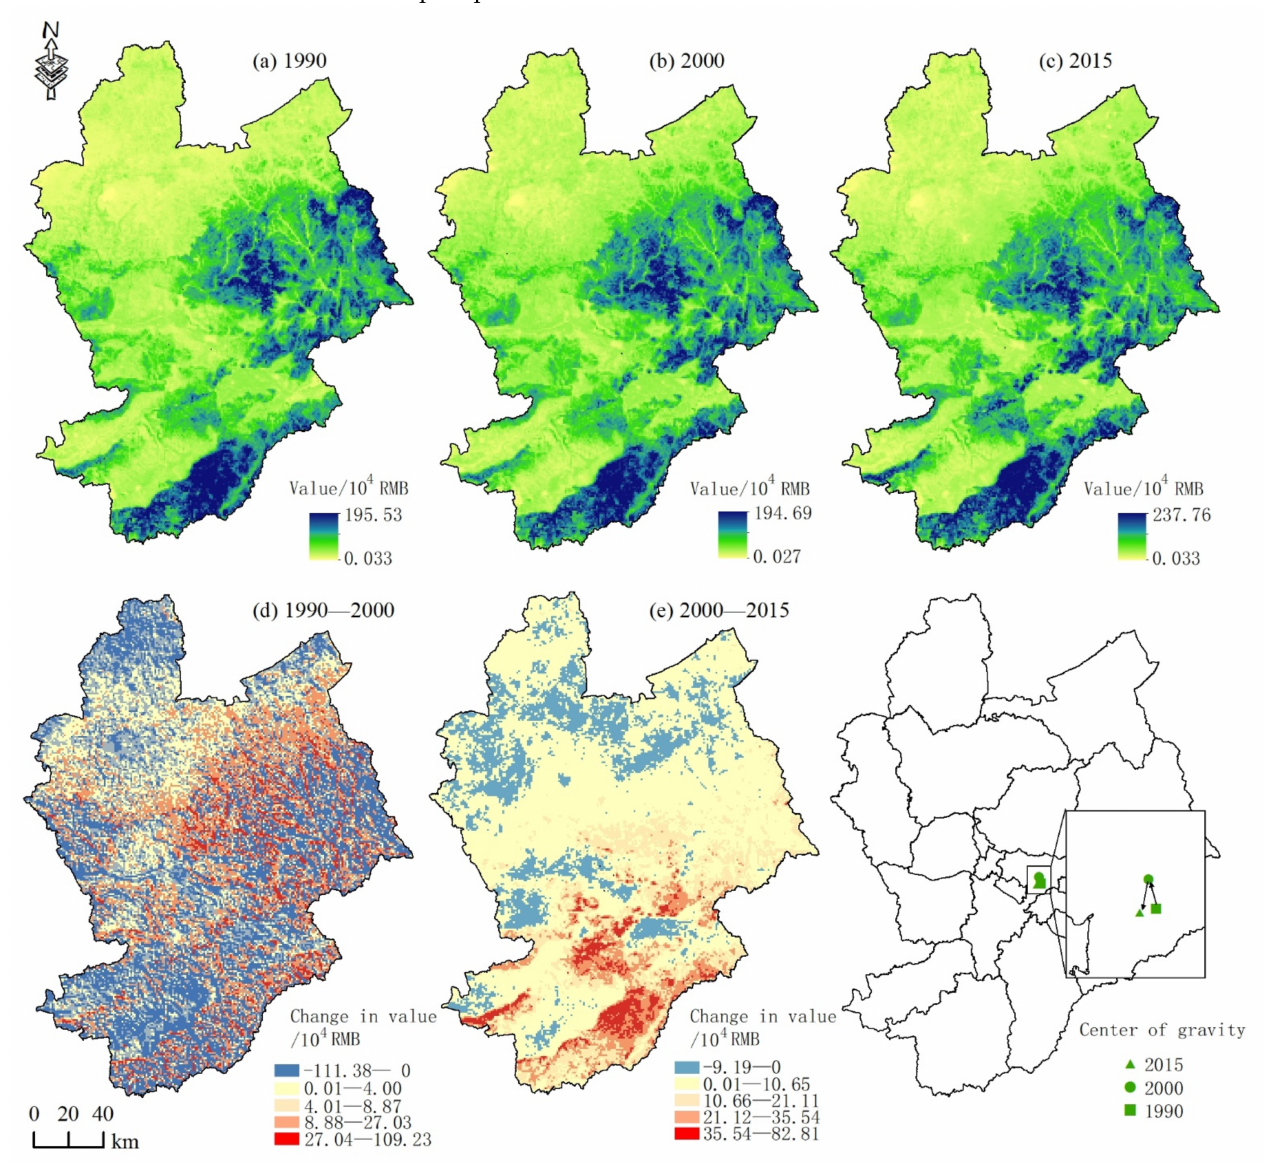
Figure 5. Spatial evolution of land use ecological function at grid scale in Zhangjiakou City in